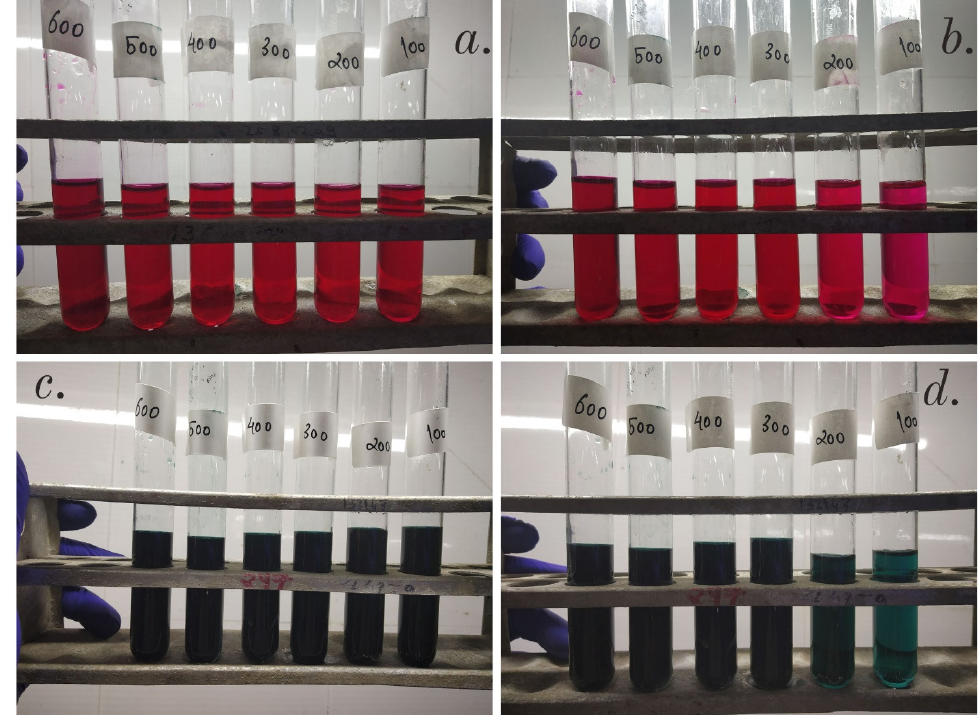
Fig. 15. Dye degradation at different concentration a) Red M8B before treatment with CuNPs, b) Red M8B after treatment with CuNPs, c) Reactive Green before treatment with CuNPs,d) Reactive Green after treatment with CuNPs.